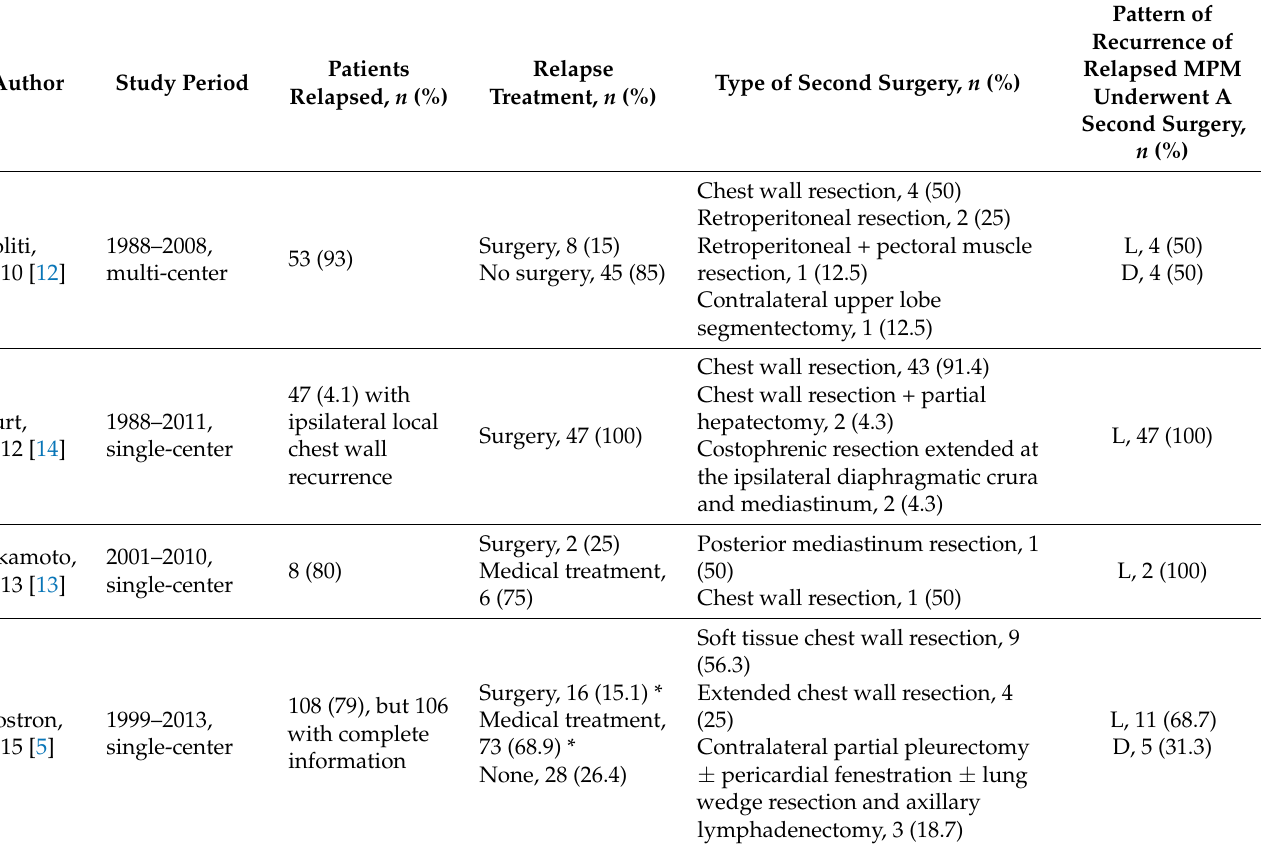
Table 1. The recurrent MPM and relapse